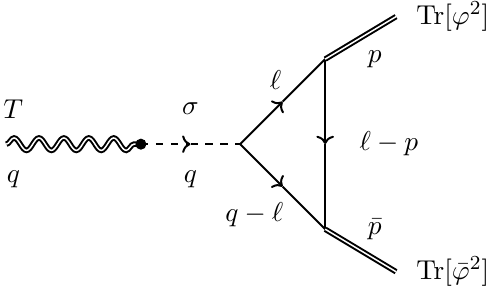
in the 4D N = 2 2(cid:22)2